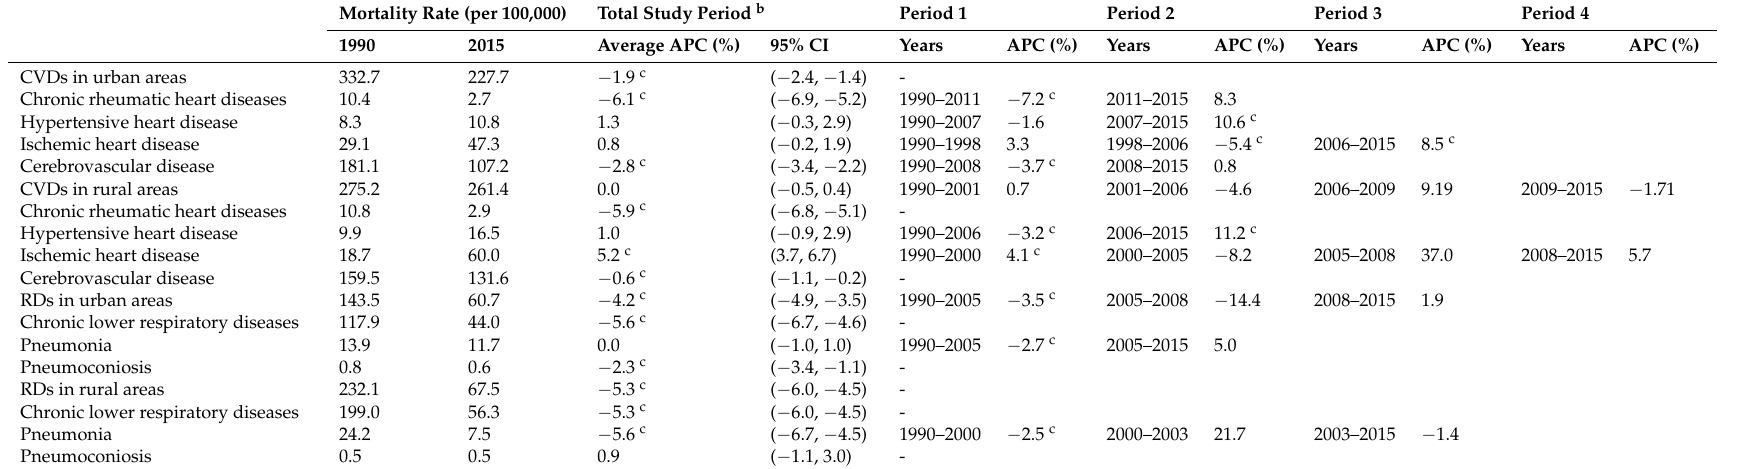
Table 1. Joinpoint analysis of age-standardized a mortality rates from CVDs and RDs in urban and rural